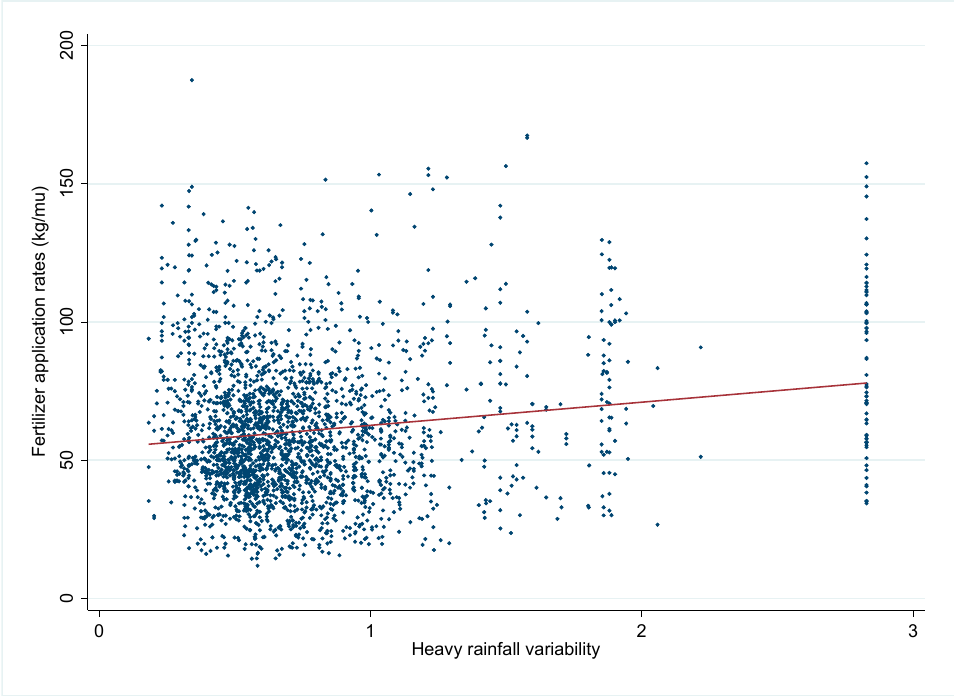
Figure 3. The relationship between heavy rainfall variability and fertilizer use.